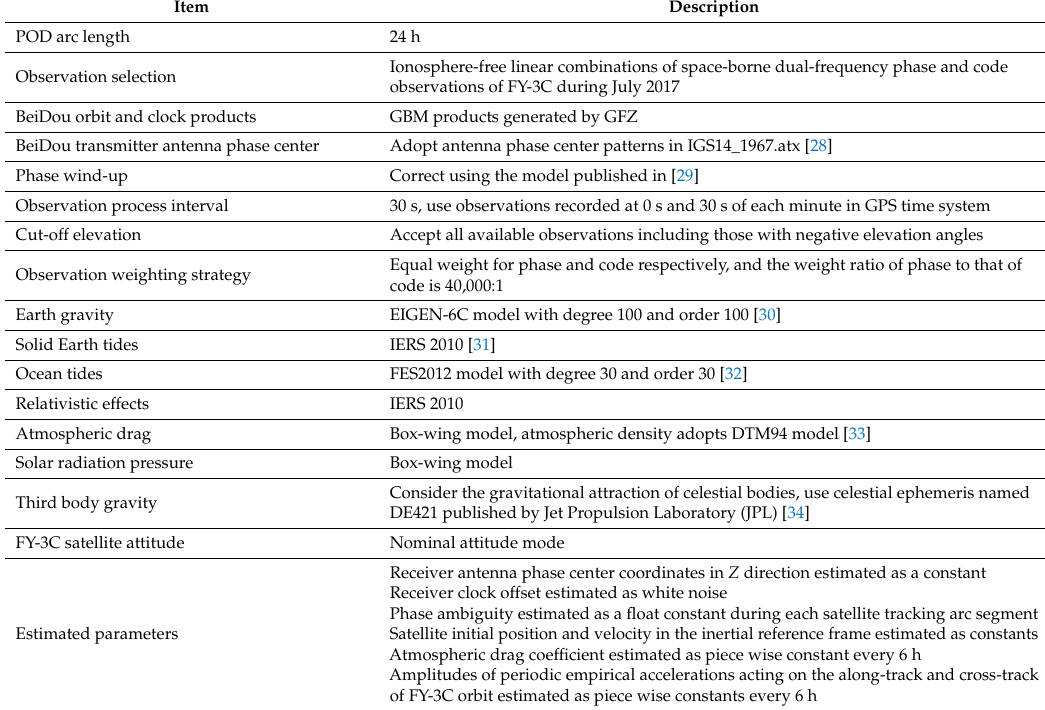
Table 2. Concepts of reduced dynamic orbit determination for FY-3C using BDS